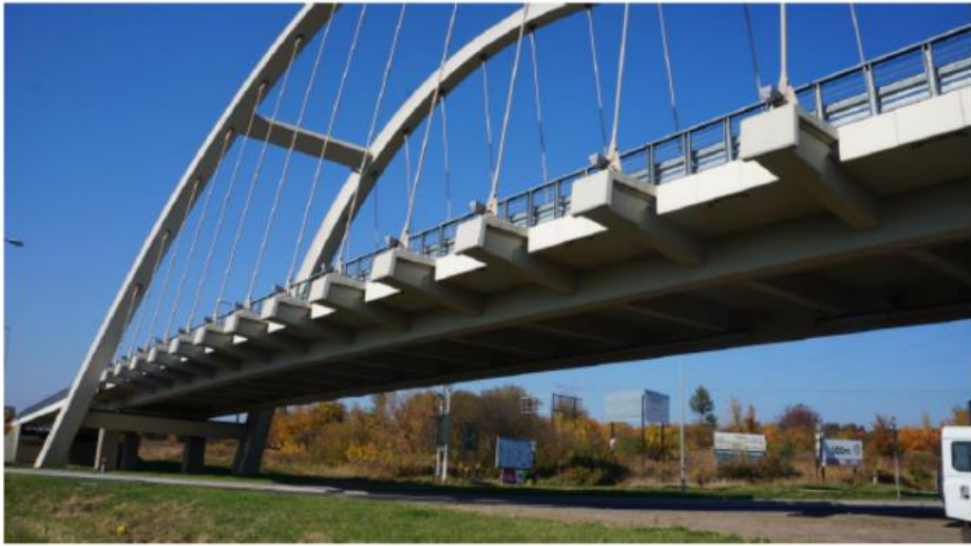
Figure 4. The analyzed five-span arch bridge with two girders prestressed by steel tendons.